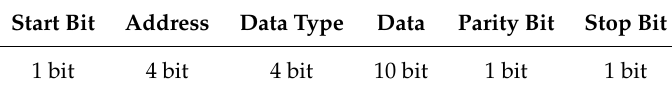
Table 3. Definition of data